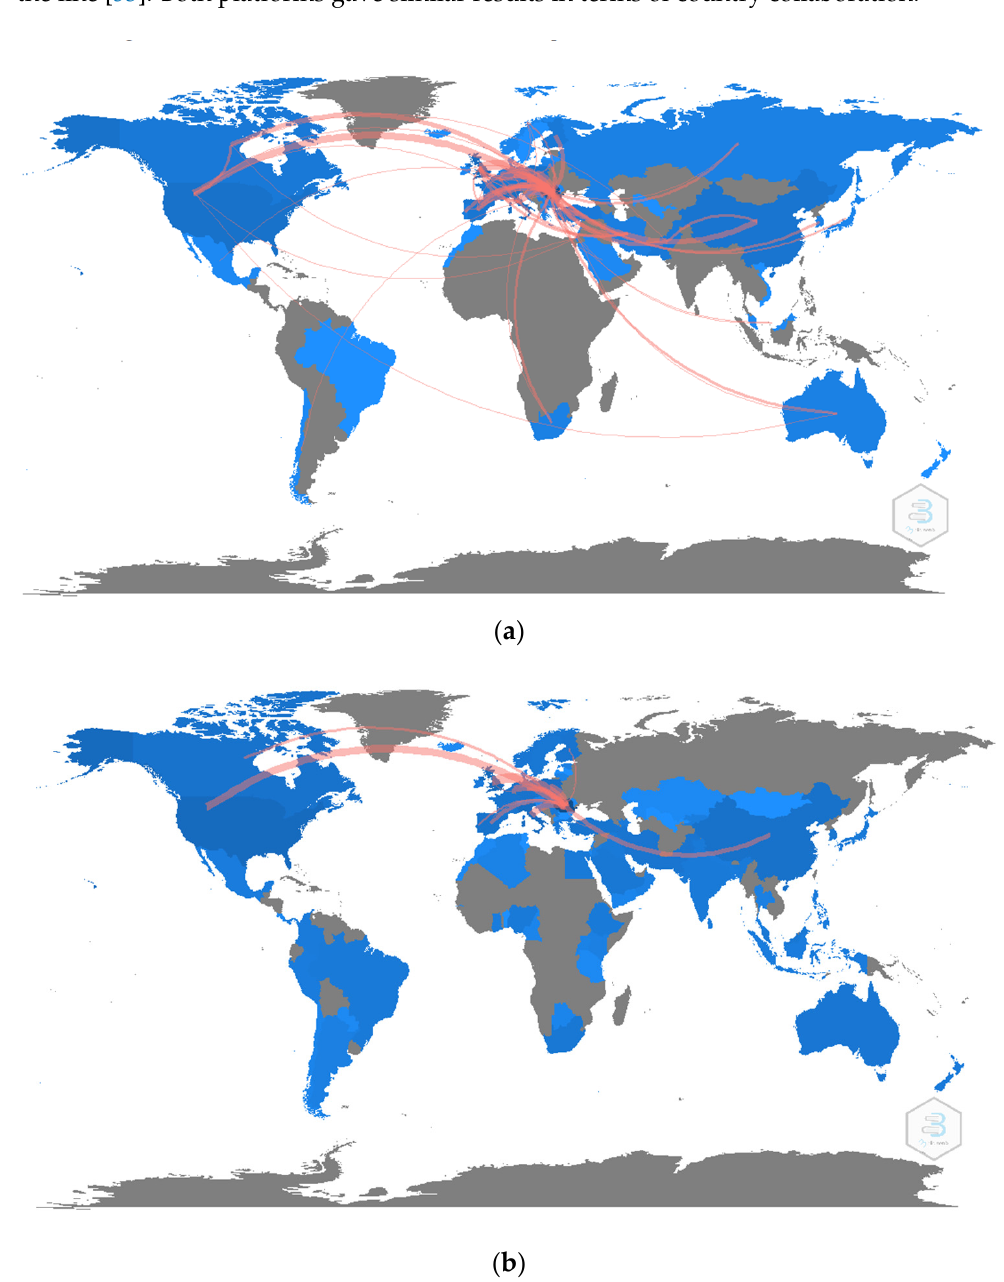
Figure 16. Collaborative network of countries. ( a ) WoS. ( b ) Scopus.